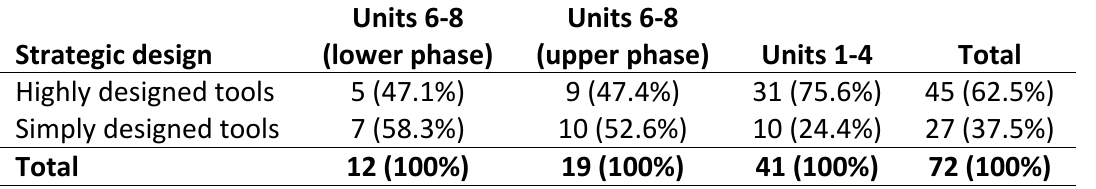
Table 3: Distribution of ground stone tool level of design in Fazael 2 by units and phases (excluding basalt bowls and spindle whorls, which are strategically designed by